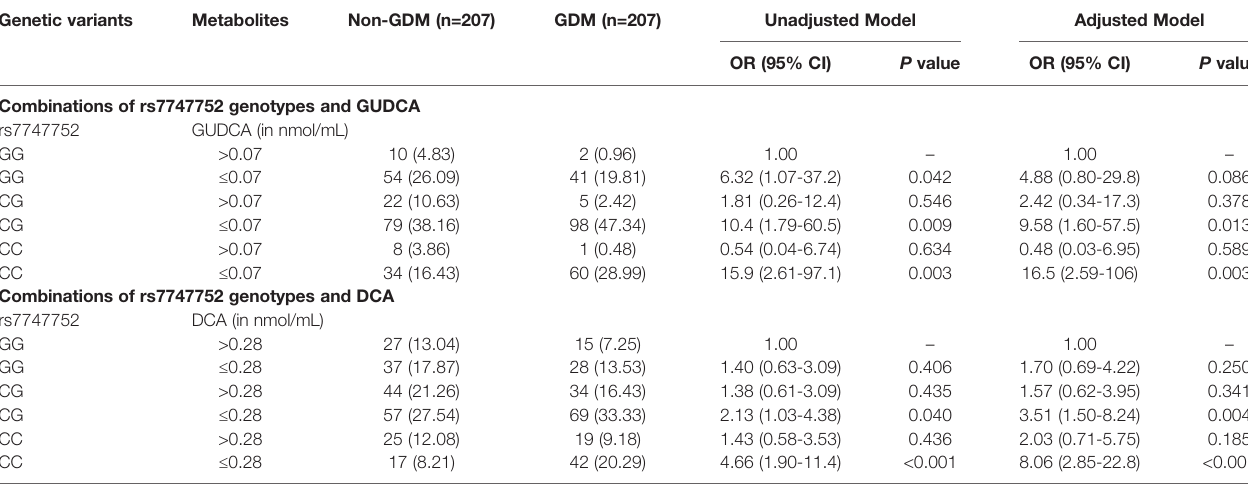
TABLE 3 | Risk associations of combinations of rs7747752 genotypes (CC vs. CG vs. GG) and low serum levels of GUDCA/DCA with gestational diabetes mellitus. Genetic variants